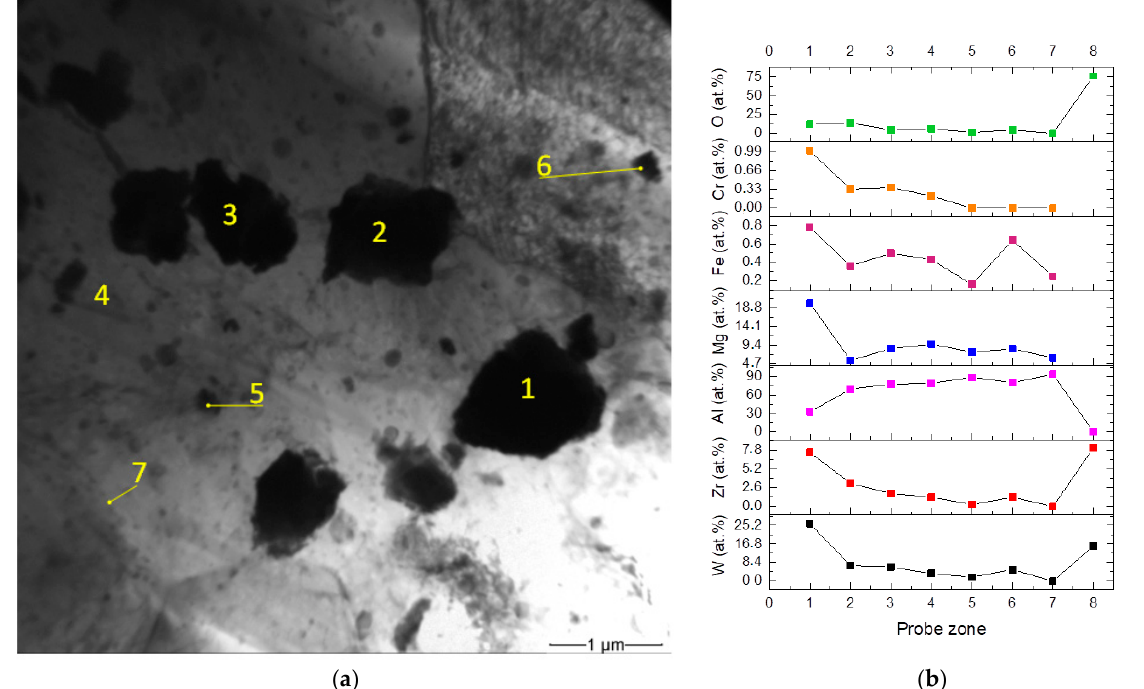
Figure 13. TEM image of stir zone metal after 8-pass FSP ( a ) and EDS elemental concentrations ( b ) in probe zones indicated in ( a ). Probe zone 8 is shown to reproduce the composition of the as-received ZrW 2 O 8 .